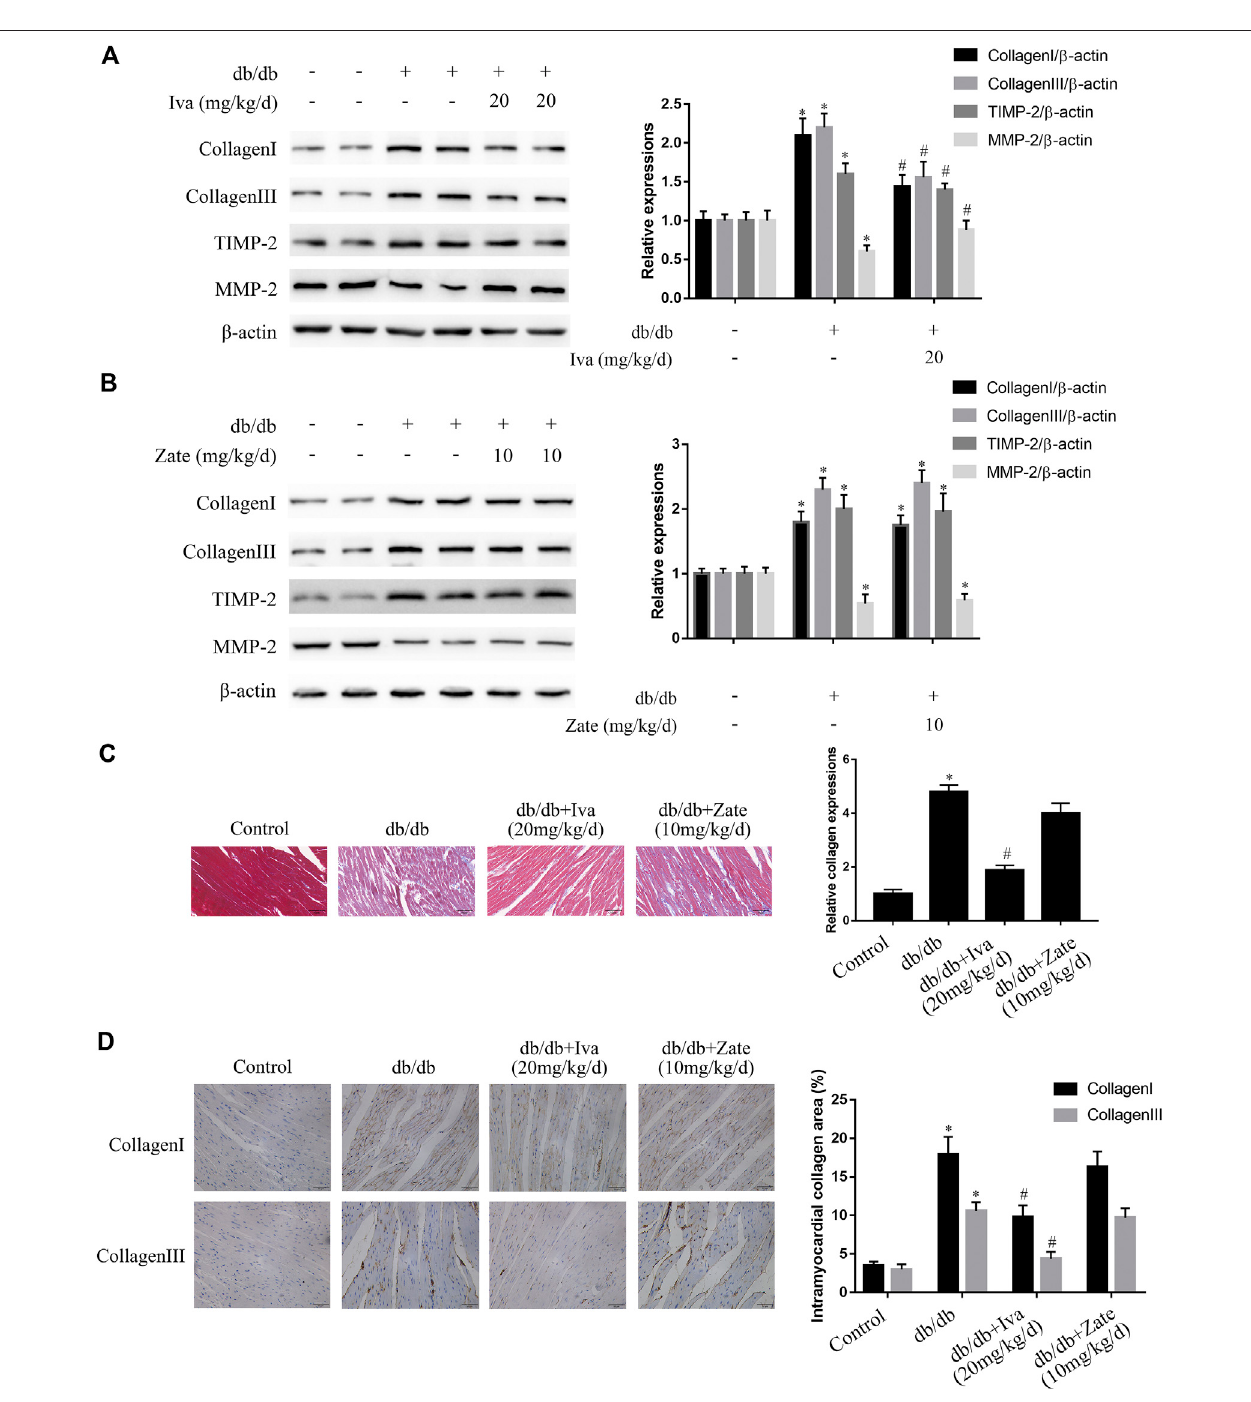
FIGURE 7 | Ivabradine, but not zatebradine, ameliorates the diabetes-induced increases in fi brogenic protein expression and fi brosis (A) Collagen I, collagen III, TIMP2,andMMP2proteinexpressionwasdeterminedbywesternblottinginleftventricular fi broblastsisolatedfrommiceadministeredivabradineattheindicateddoses (B) Left ventricular fi broblasts were isolated from mice administered zatebradine at the indicated doses and the expression of the proteins listed in (A) wasmeasured by western blotting (C and D) Mice were treated as described in (A) and (B) and the degree of cardiac fi brosis was determined by Masson ʼ s trichrome staining and immunohistochemistry.Thecolumnsshowthedifferencesincollagenaccumulation(originalmagni fi cation × 400).Scalebars,50 μ m.Datain (A – B) ( n (cid:2) 3)and (C – D) ( n (cid:2) 6) arepresented asmean ± SEM. p -valueswerecalculatedusing one-wayANOVA with Tukeymultiple comparison test. * p < 0.05, compared totheControlgroup; # p < 0.05, compared to the db/db mouse